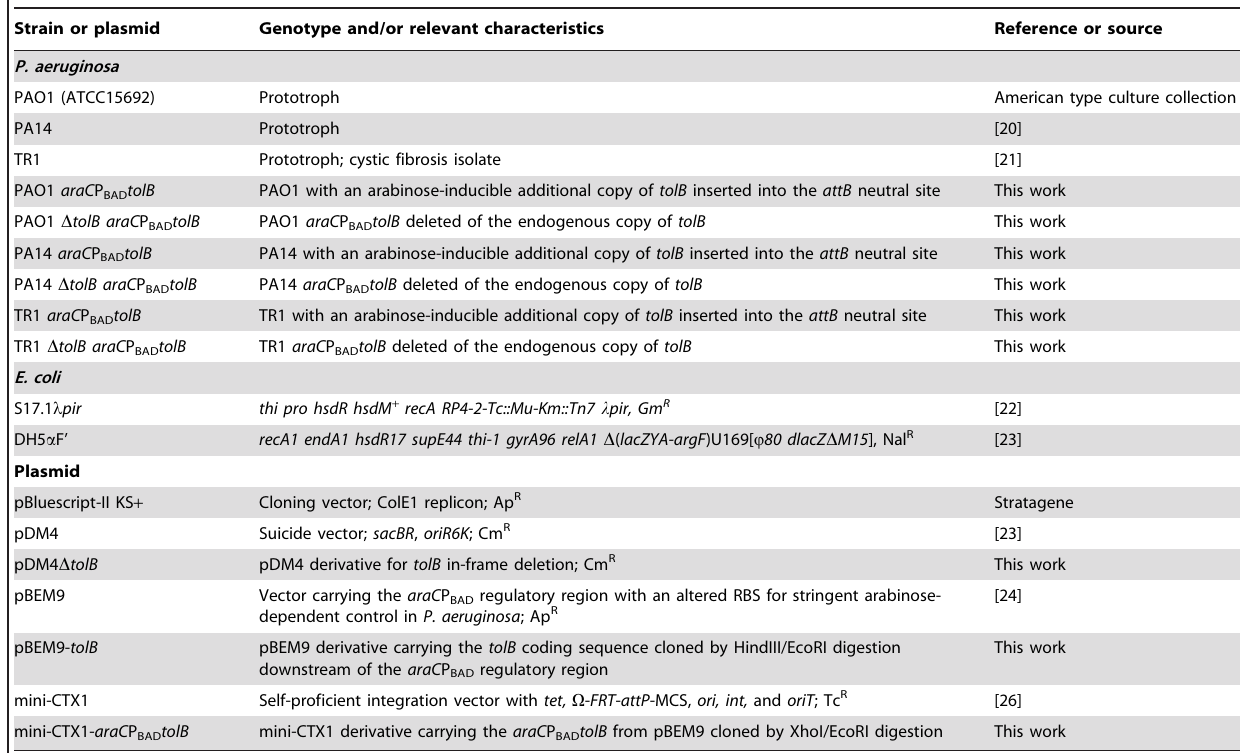
Table 1. Bacterial strains and plasmids used in this